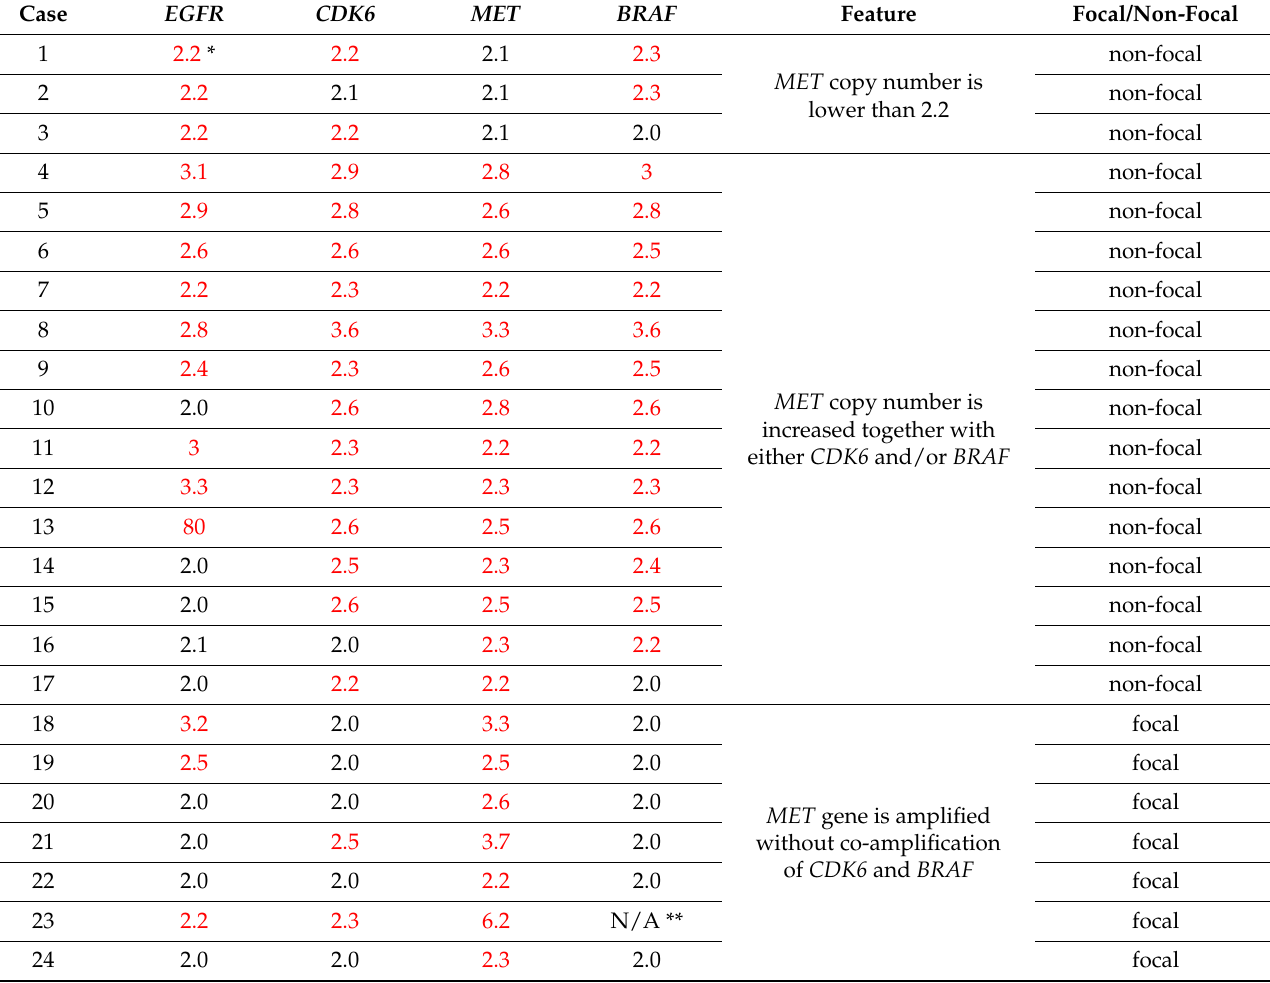
Table 2. Patterns of copy number of four genes on chromosome